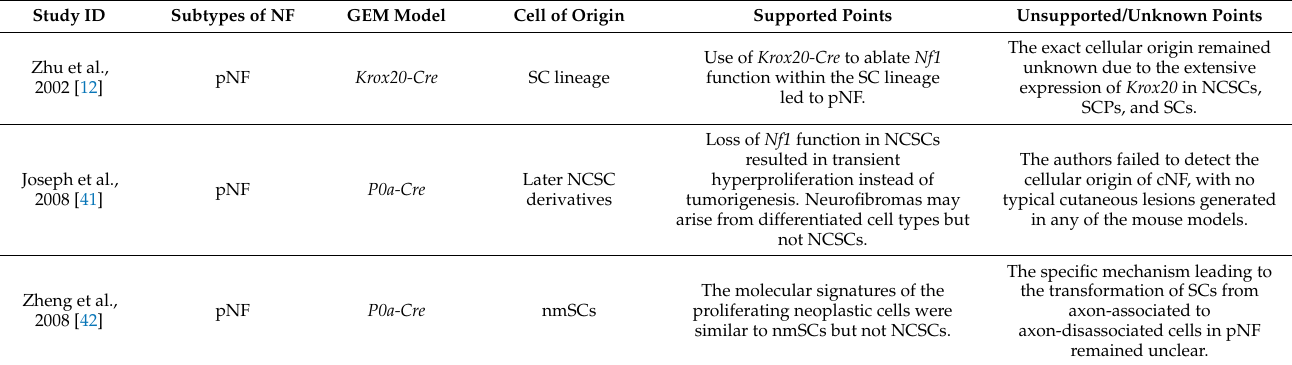
Table 1. The summarized study progress on the cellular origin of